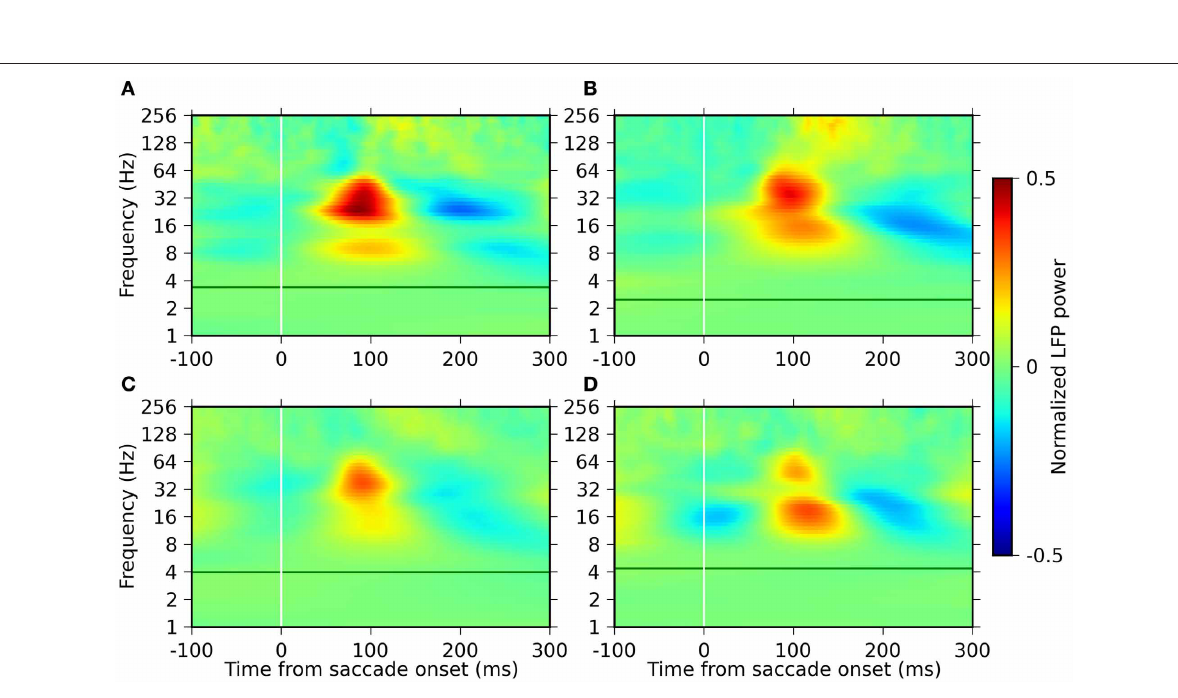
FIGURE 3 | Time-frequency plotsof theLFP powermodulationaround saccade onsetforthe fourmonkeys. Panels (A–D) represent the results of monkeys D, S,M,and G, respectively. The power is normalized (mean-